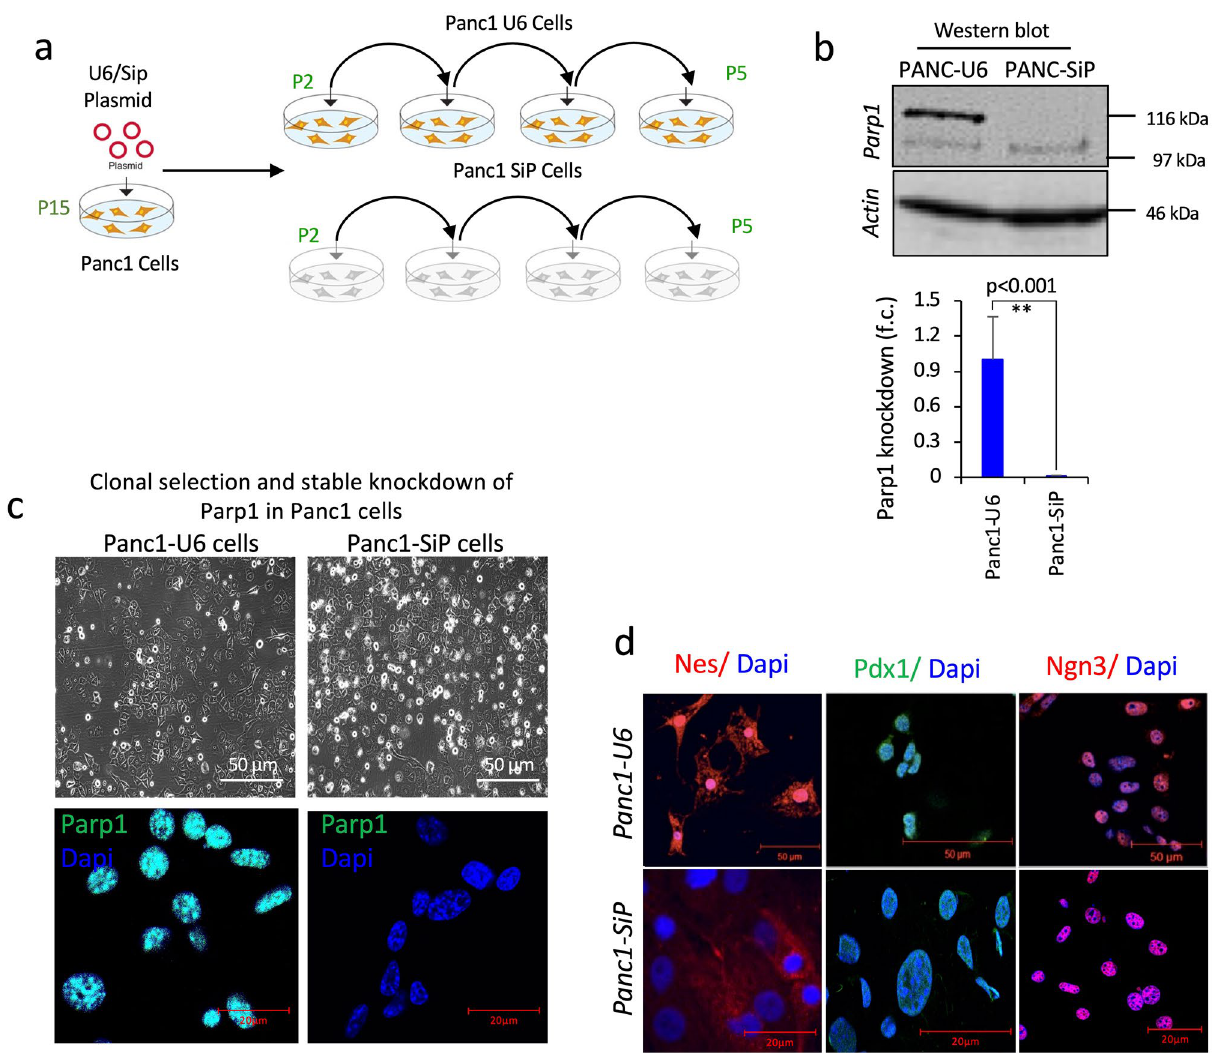
Figure 2. Creation of PARP1 +/+ (U6) and PARP1 −/− (SiP) cells for functional characterization. ( a ) Schematic representation for clone generation, selection, and isolation after PARP1 silencing using SiP and mock U6 shRNA control. Cells for experimentation were confirmed for absolute PARP1 depletion at passage 5. ( b ) Immunoblot confirmation of PARP-1 depletion in SiP and U6 cells. The graph represents quantification for PARP1 depletion in most established clones after 3 independent passages. Data represented as mean ± sem, p-value show significance at 95% confidence interval using ttest analysis compared to U6 cells (n = 3). ( c ) Phase contrast images for PARP1 control and deplete SiP-PANC-1 cells showing morphological changes after KD. Fluorescent staining show images for PARP-1 (green). ( d ) Immunocytochemistry images for pancreatic progenitor- nestin (red), pdx1 (green), and ngn-3 (red) in PANC-1 U6 and SiP